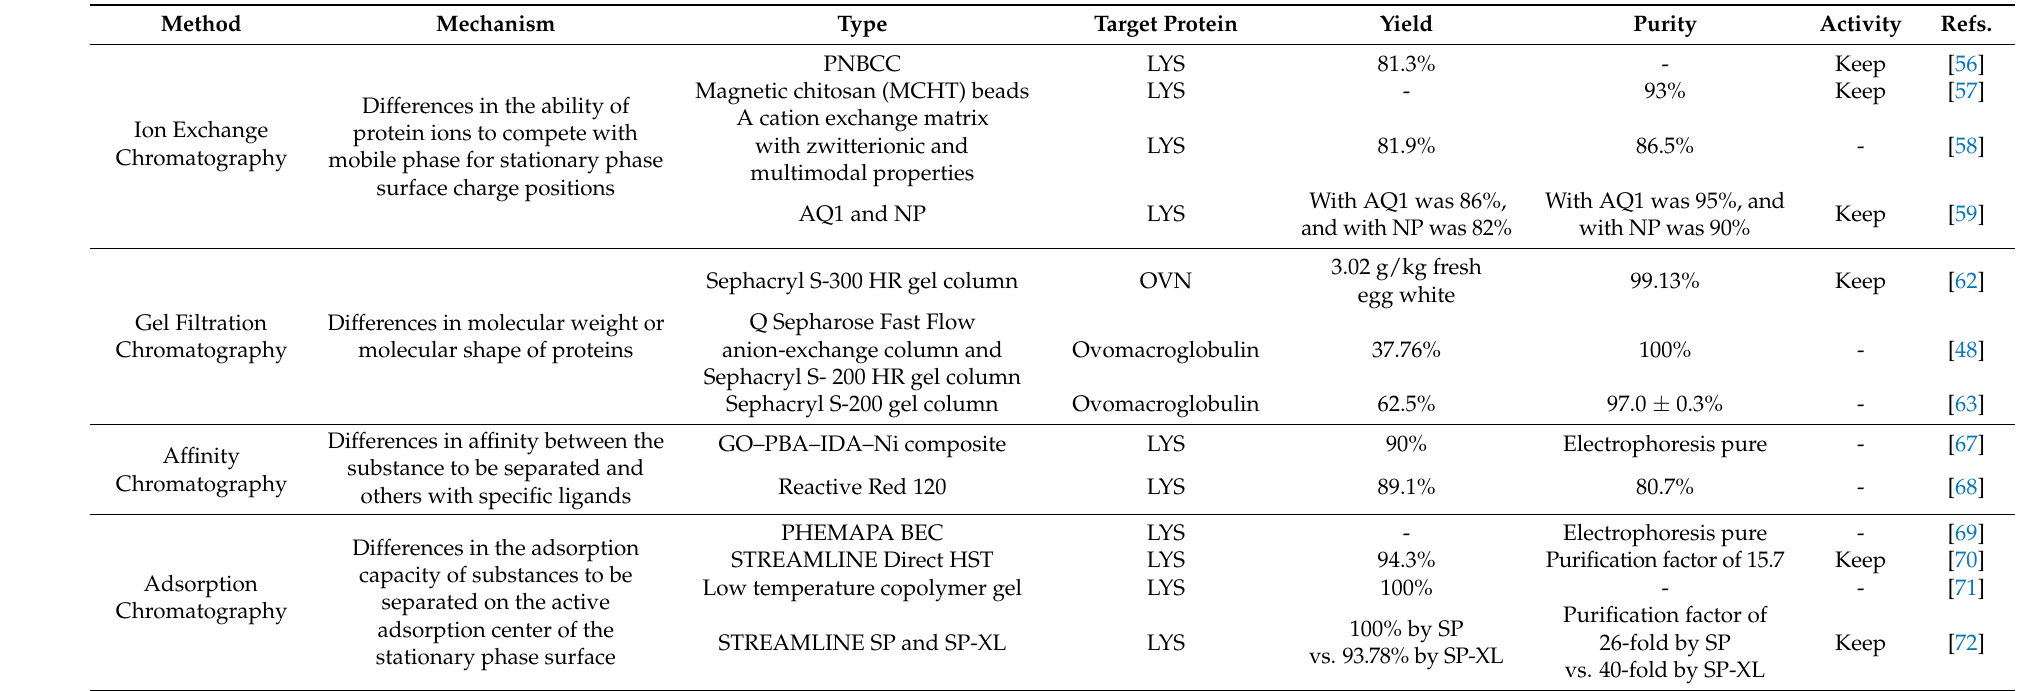
Table 2. Applications of